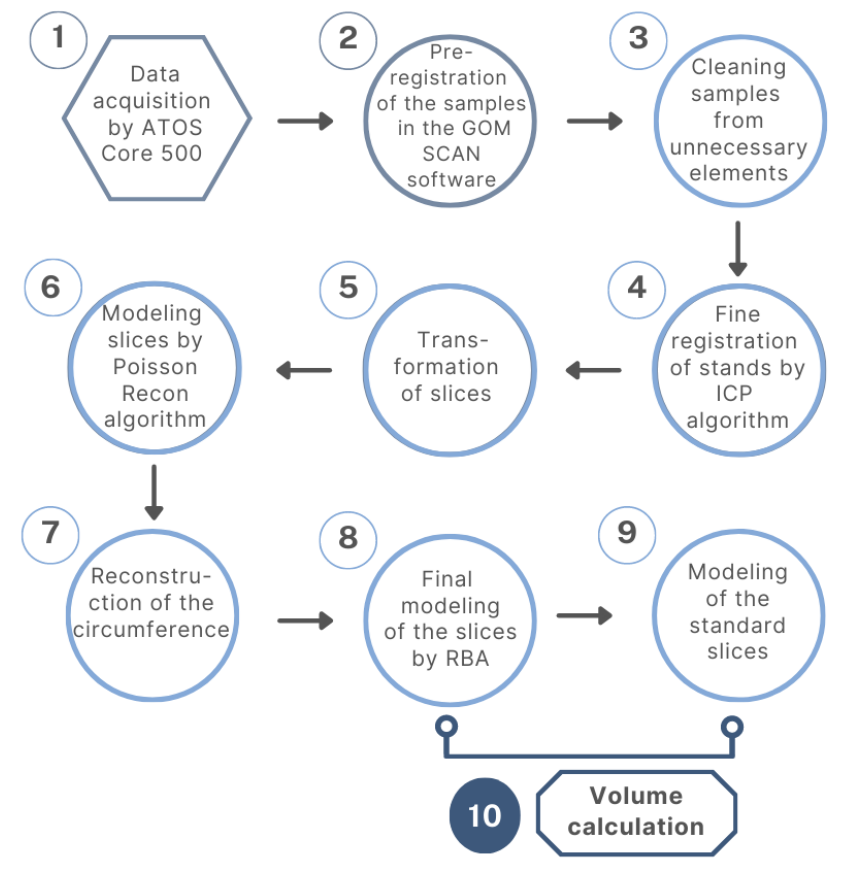
Figure 4. Scheme of data processing for modeling and calculation of volume and porosity of the geological core.